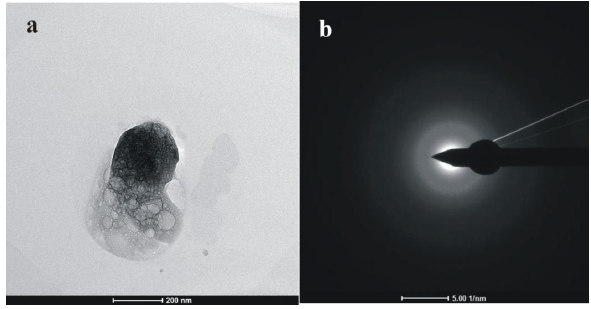
Figure 5. Panel (a) shows the TEM image and (b) SAED pattern of an S-, O-, K- , Na-, and Pb-containing particle obtained from an ascending gas flow above the soil over the Dongshengmiao